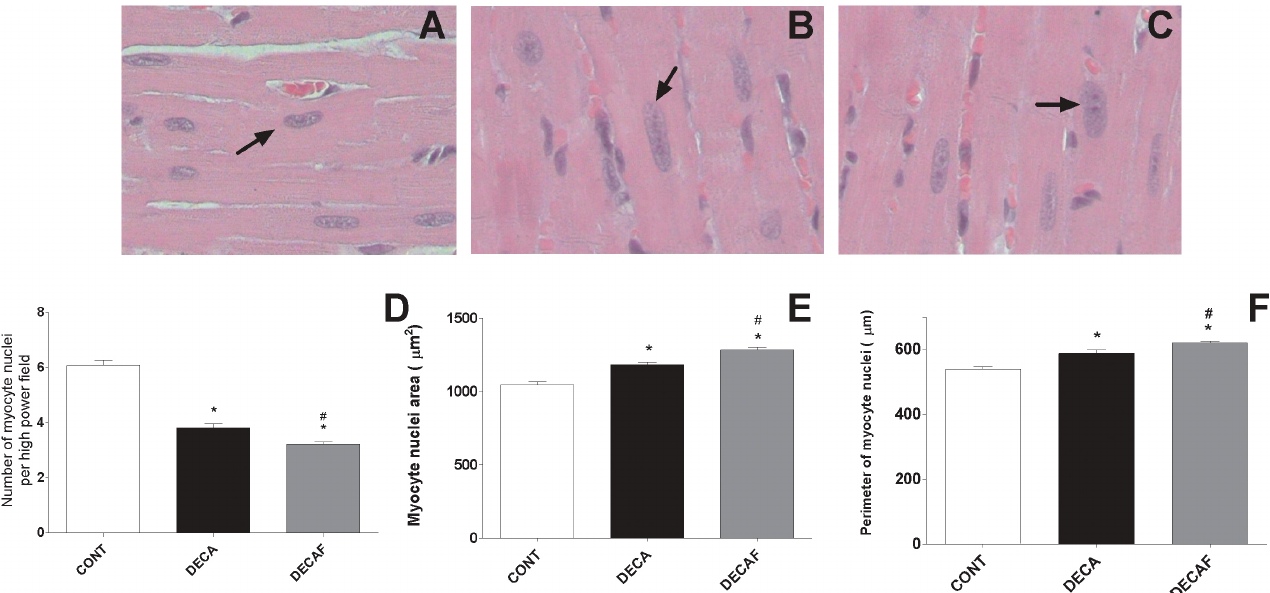
FIGURE 1 - Results of the morphometric analysis of the left ventricle of animals treated with ND and finasteride. Representative samples of the histologic analysis (Panels A-C); the arrows indicate the representative nucleus in the histologic samples. Panel D: Analysis of the number of cardiac myocyte nuclei after treatment with the combination of ND and finasteride compared to that of the control group. Panel E: Area of myocyte nuclei after treatment compared to that of the control group. Panel F: Perimeter analysis of the myocyte nuclei after treatment. *p< 0.05 compared to the control group. # p<0.05 compared to the DECA group.